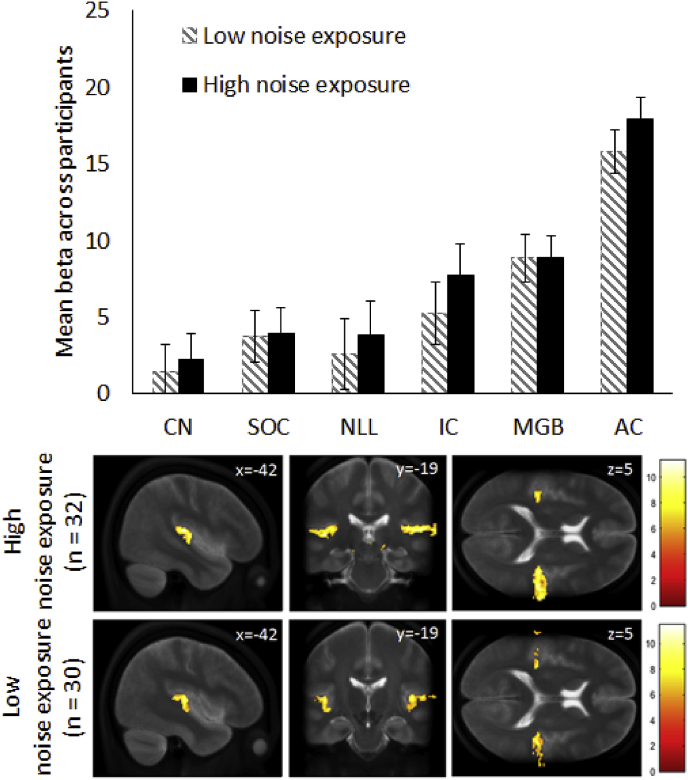
Onset response: estimated marginal mean ROI beta values for stimulus onset in ROIs in low and high noise exposure groups. Beta values represent an average over left and right hemispheres, error bars represent the 95% confidence intervals of the mean. Random effects group activations to the stimulus onset for the low (n = 30) and high (n = 32) noise exposure groups threshold at p < 0.05 FWE corrected with the color bar showing the T statistic. Numbers within the images denote co-ordinates of sagittal, coronal and transverse slices. Statistical maps are overlaid on the mean (n = 62) T2 TSE image.